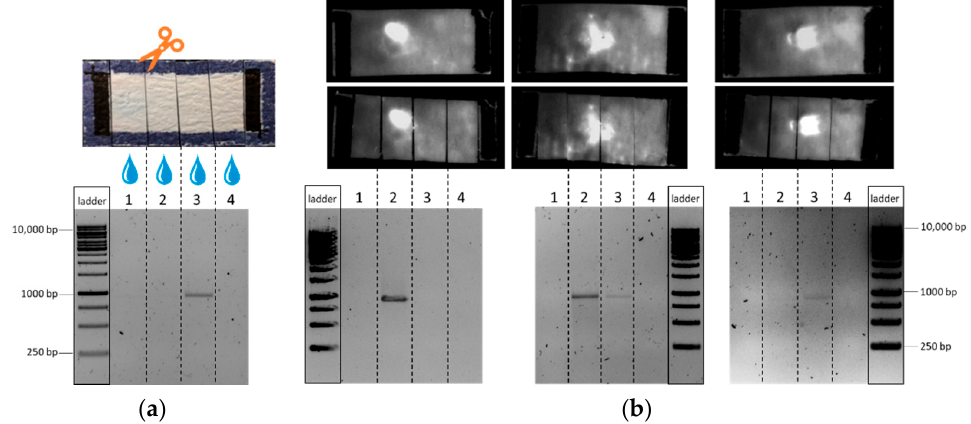
Figure 7. Images of a 910 bp DNA fragment amplified from Legionella pneumophila Philadelphia as a sample in fiber-based electrophoresis with measurement setup 2 and alternative visualization using post-staining with intercalating dye GelRed. ( a ) The fragment visualized on an 1% agarose gel after elution from the chip area. ( b ) Alternative visualization of the DNA fragment by staining with intercalating dye GelRed and no interference with subsequent elution.